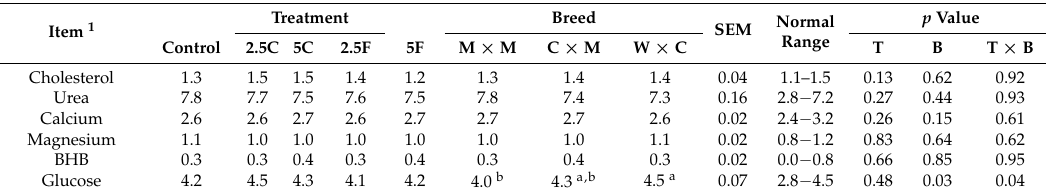
1 As indicated in Table 2; BHB: Beta–hydroxybutyrate. Row means bearing different superscripts within a fixed factor significantly differ ( p < 0.05).